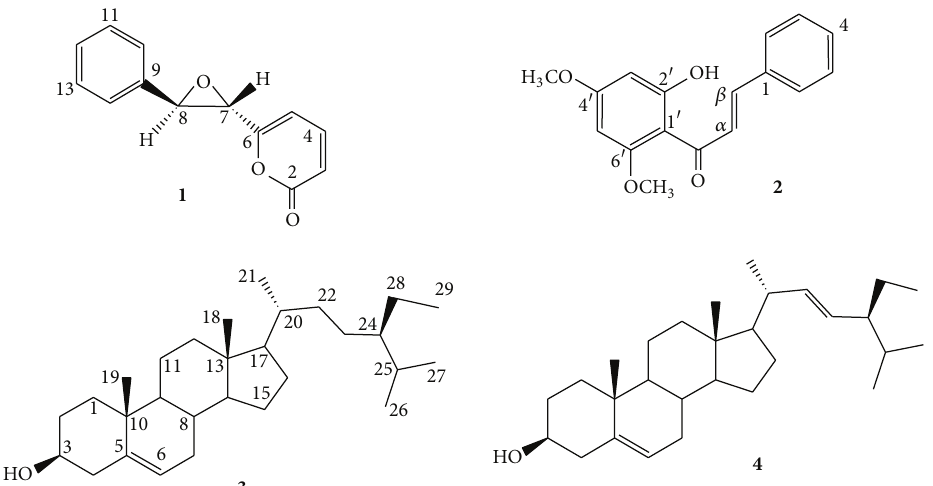
Figure 1: Structures of the secondary metabolites 1 – 4 isolated from P . dilatatum .